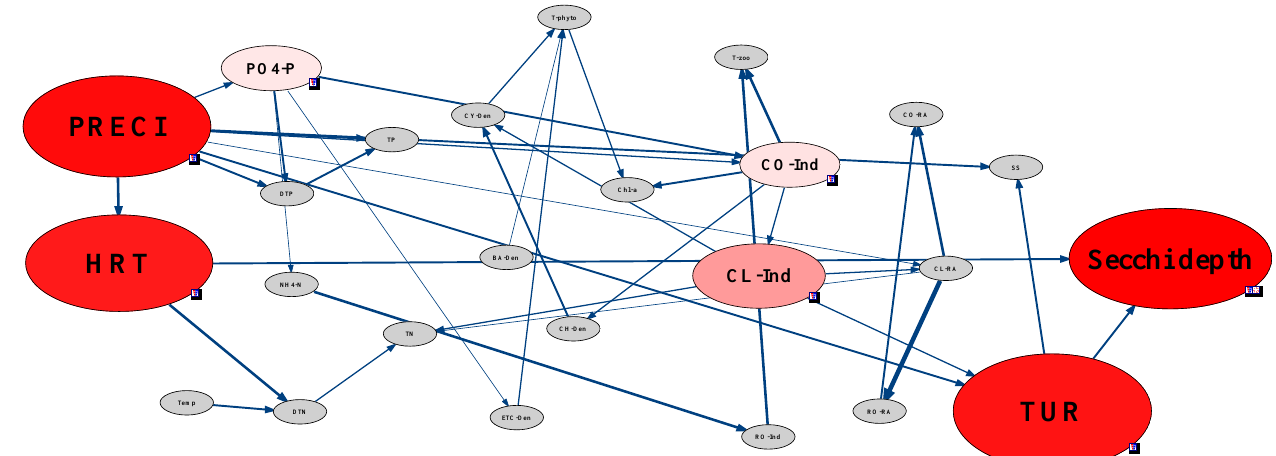
Figure 7. Sensitivity test and strength of influence analysis using the Bayesian network approach for assessing the CWP in St. 3, which was at the junction between the Bukhan River and Lake Paldang. All data for St. 3 used in the Bayesian network were discretized using a hierarchical method and bin count 3.